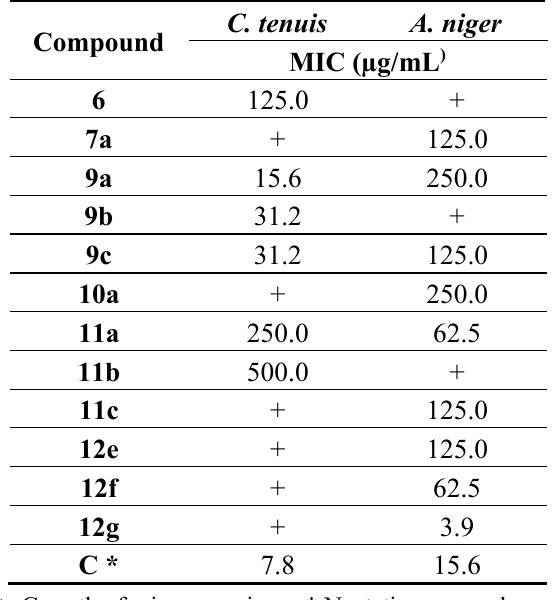
Table 3. Fungicidal activity of the synthesized compounds determined by serial dilution method (only compounds that gave positive results at least in one case are included in the